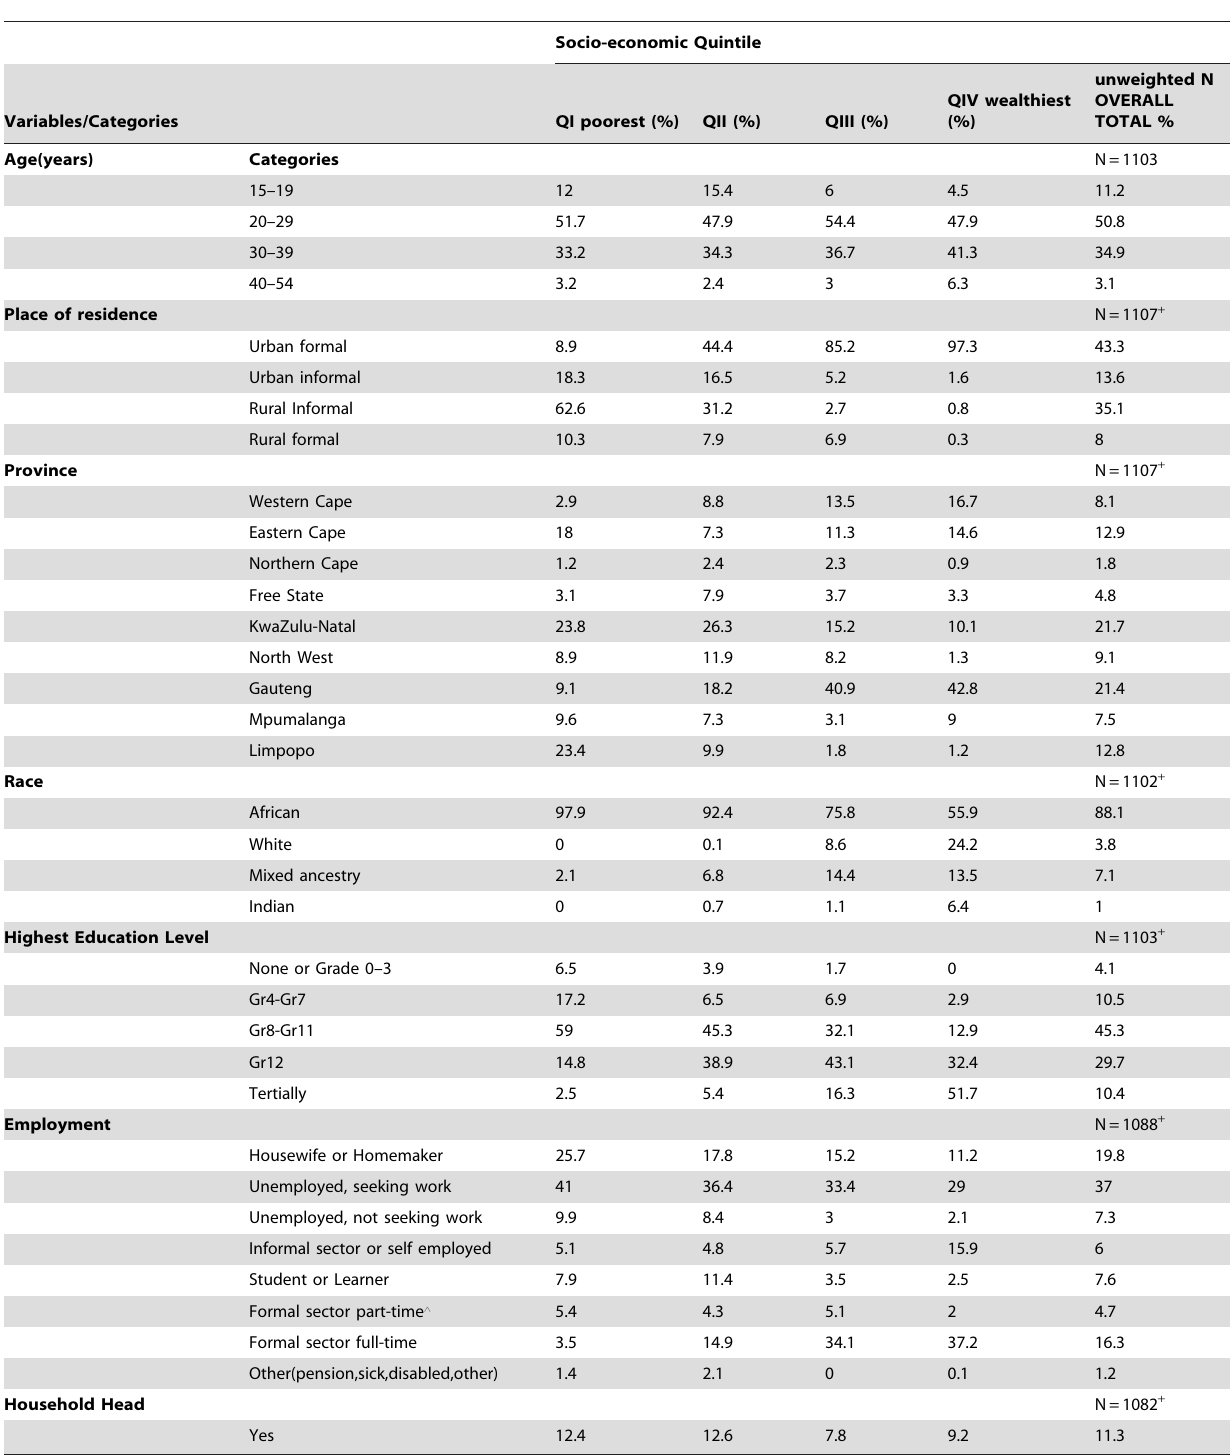
Table 1. Distribution of socio-economic status among population sub-groups of women pregnant in past two years: analysis of the 2008 national SABSSM